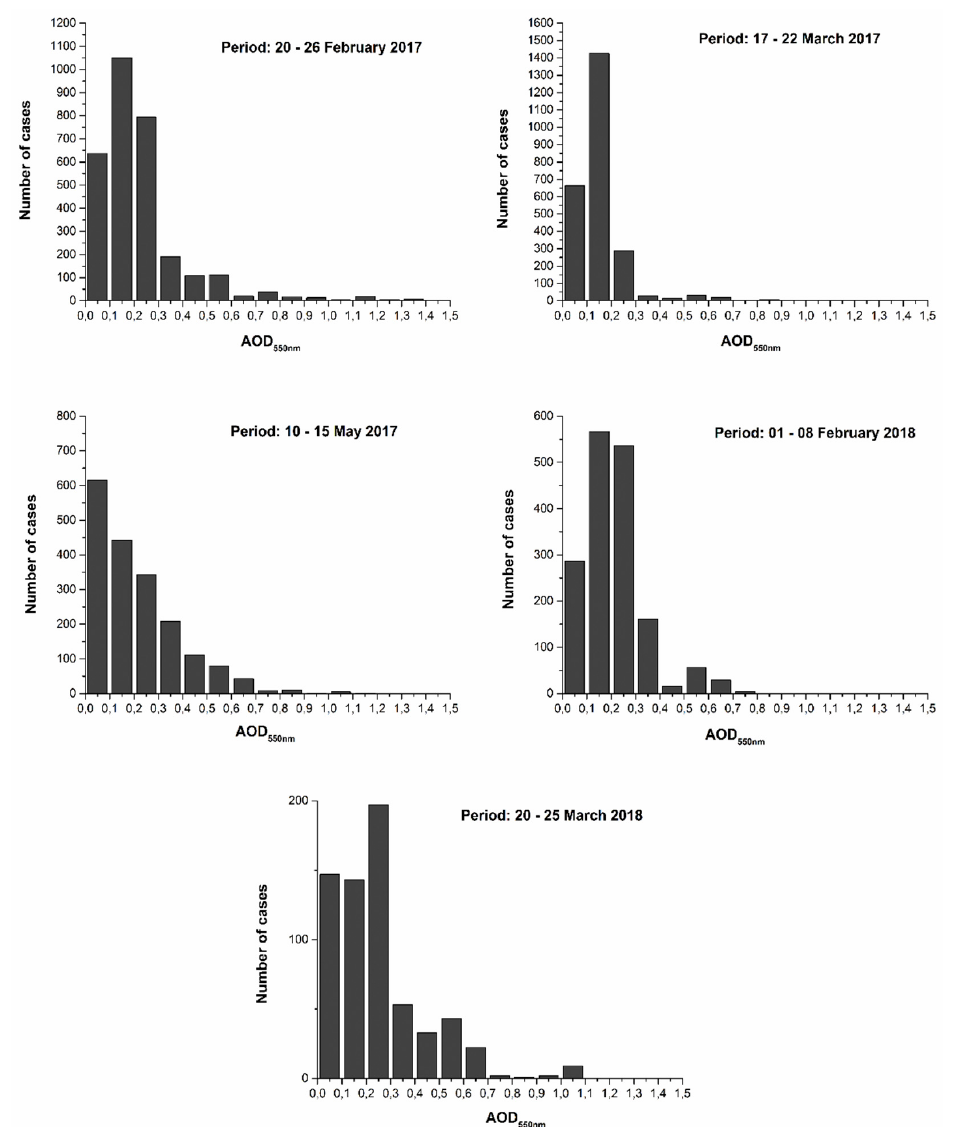
Figure 2. The frequency distributions of AOD 550 nm values for the 14 used AERONET stations during the five examined periods with dust outbreaks in the greater area of the central and eastern Mediterranean.